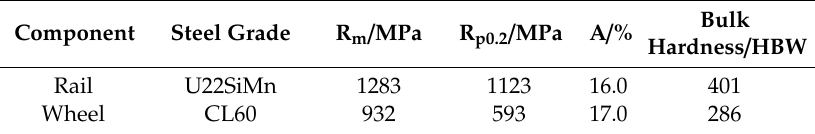
Table 2. Mechanical properties of selected rail and wheel